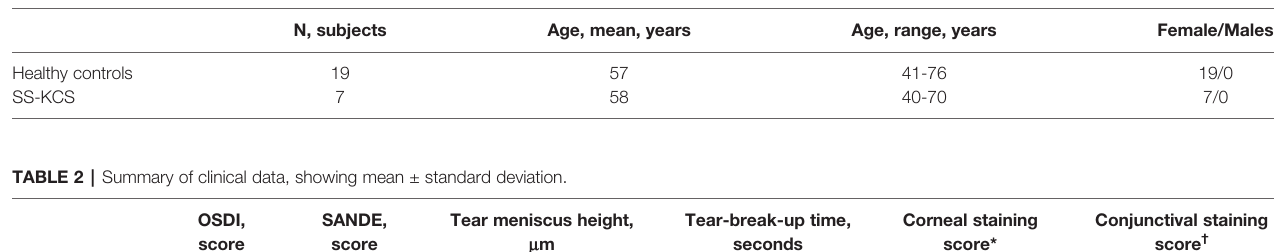
TABLE 1 | Demographic Characteristics of Study Groups.